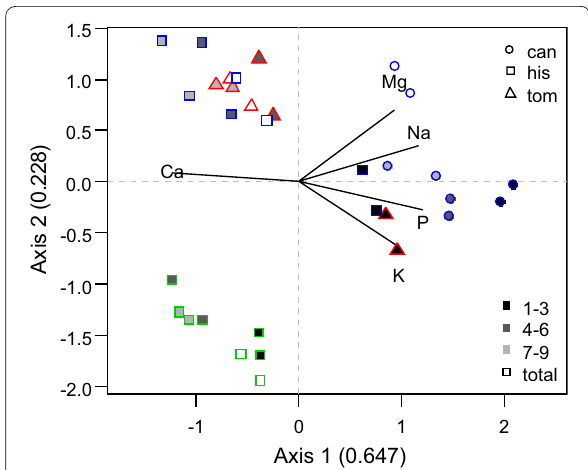
Fig. 3 PCA plot of element contents (Ca, K, Mg, Na, and P) of charophytes from Angersdorfer Teiche (blue), Asche (red), and Bruchwiesen (green). Species were plotted with different symbols; background of symbols indicates parts of thallus, see